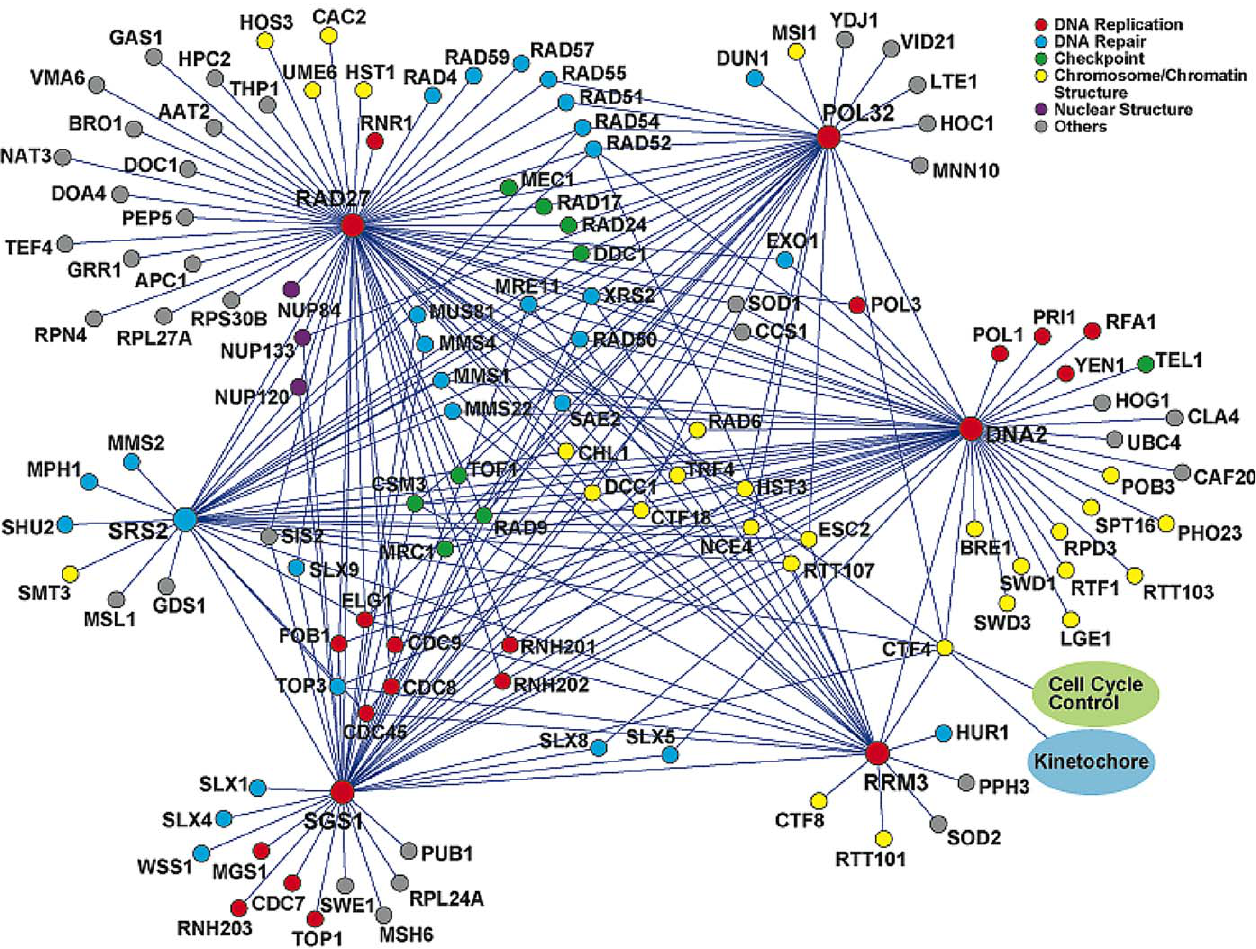
Figure 2. A Genome Stability Network